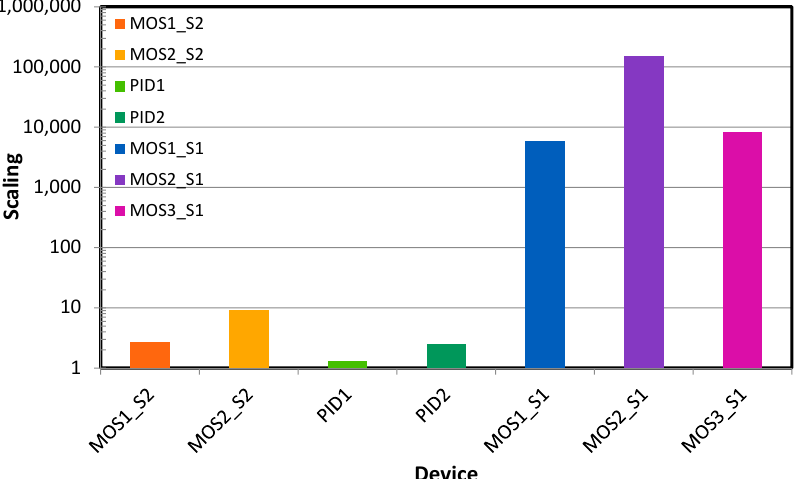
Figure 15. S = S sensor /S tenax calculated for TVOC concentration = 85 µg/m 3 equivalent toluene for the TVOC sensors.